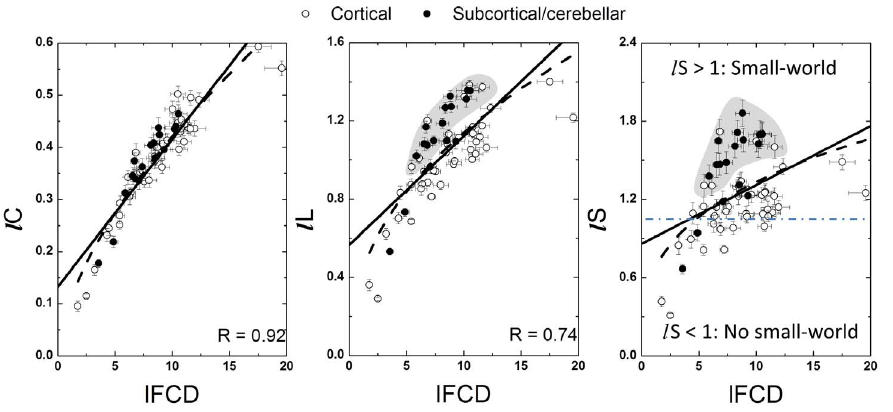
Figure 4. Association between graph-theory measures from anatomical ROIs. Scatter plots showing the linear (solid line) and non-linear (negative power scaling, dashed line) associations of l FCD with lC , lL and lS . Shaded highlights identify regions with higher small-worldness than average for a given local degree. The dash dot line indicates the boundary of the small-world topology ( lS = 1). Sample: 40 healthy children (WashU dataset), correlation thresholds: R T1 = 0. 50; R T2 = 0.65.